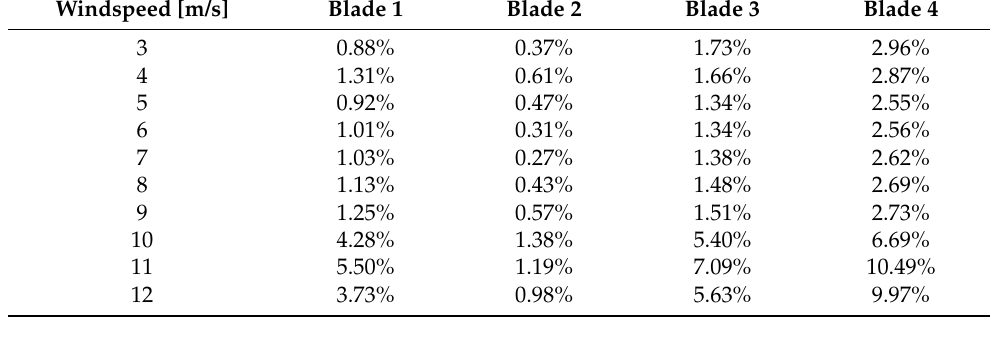
Table 4. Power production improvements before reaching the rated wind speed.